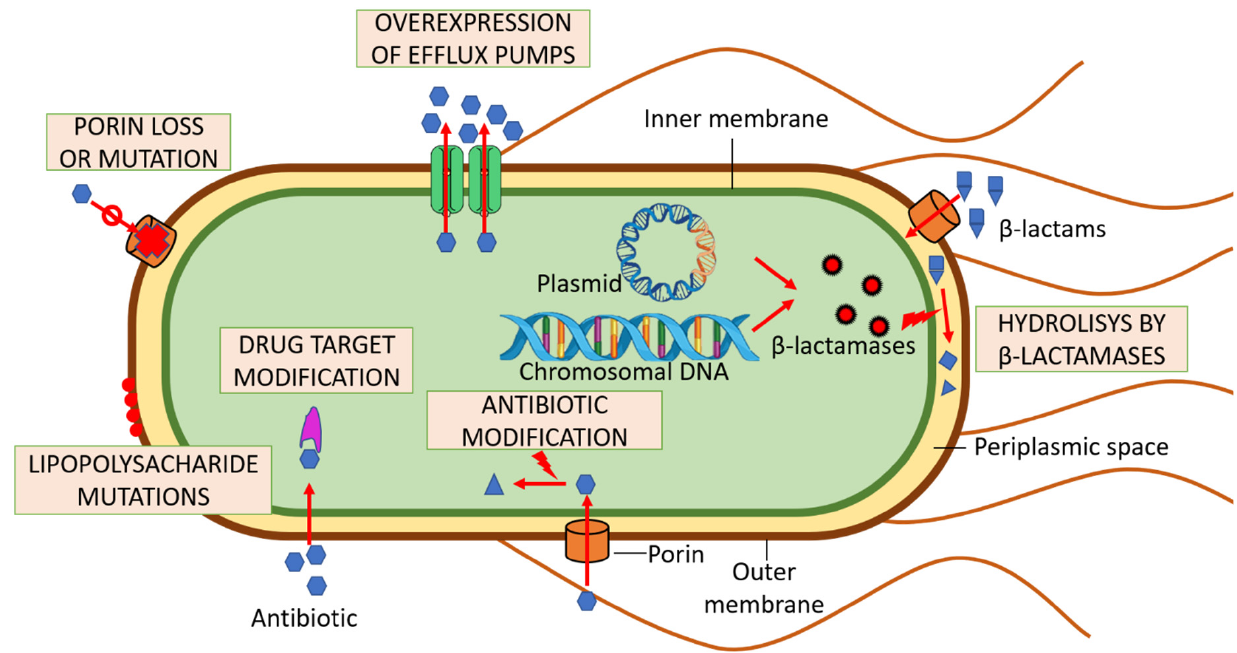
Figure 3. Various mechanisms of multi-drug resistance in E. coli. The resistance mechanisms and examples of affected antibiotic agents are: (i) efflux pumps: quinolones, tetracyclines, macrolides; (ii) hydrolysis: β -lactams, macrolides; (iii) antibiotic modification: aminoglycosides, macrolides; (iv) drug target modification: aminoglycosides, quinolones, sulfonamides; (v) lipopolysacharide mutations: colistin, aminoglycosides; (vi) porin loss or mutation: β -lactams, quinolones, tetracyclines.